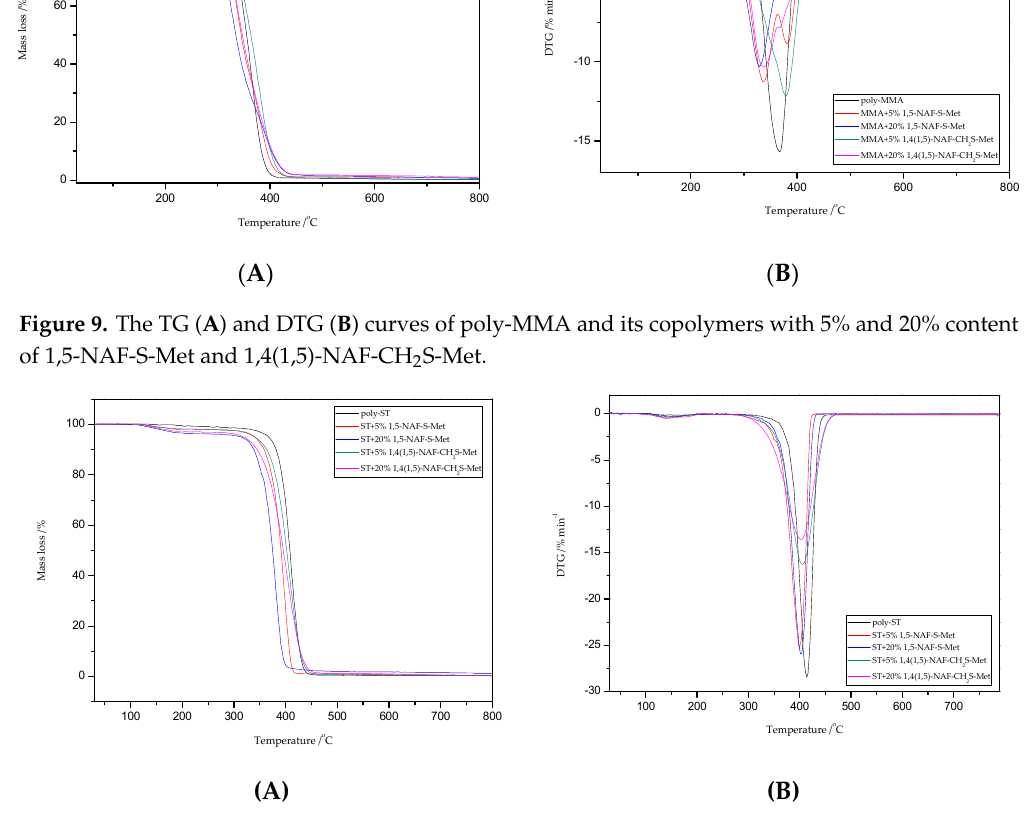
Figure 10. The TG ( A ) and DTG ( B ) curves of poly-ST and its copolymers with 5% and 20% content of 1,5-NAF-S-Met and 1,4(1,5)-NAF-CH 2 S-Met. TG / DTG curves for poly-MMA show three stages of mass loss in the thermal degradation at ◦ T max = 180; 250, and 367 C; which is consistent with the literature reports [59–61]. In addition,